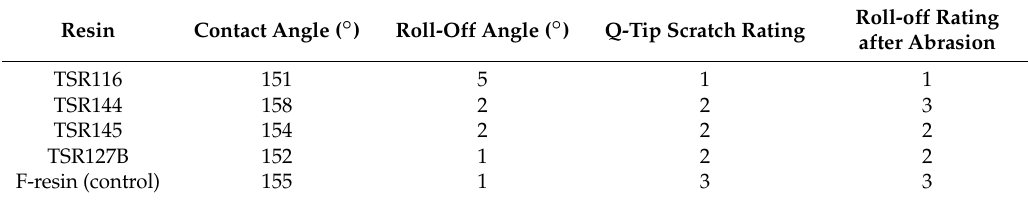
Table 2. Properties of the superhydrophobic coatings based on pure silicone resin and fluorine- functionalized colloidal silica.